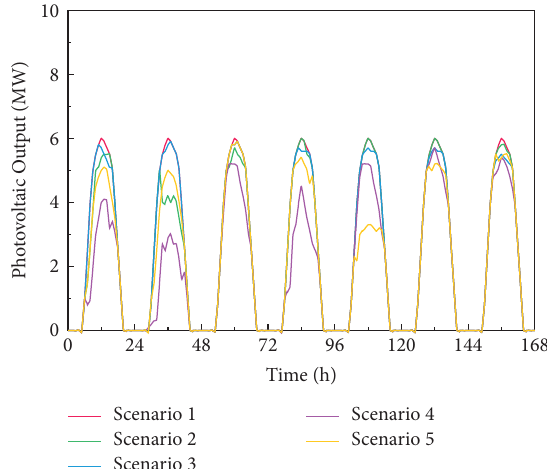
Figure 5: Photovoltaic output in diferent scenarios.